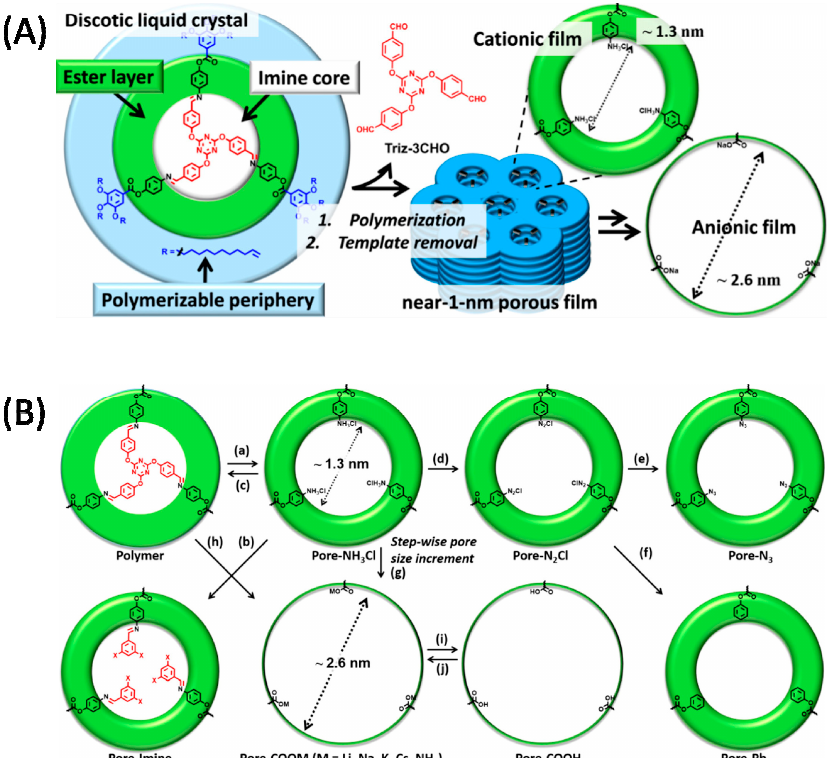
Figure 5 . Chemical pore modification of a columnar hexagonal liquid crystal polymer. ( A ) Stepwise fabrication of a nanoporous polymer with smaller cationic, or bigger anionic pores; ( B ) Scheme of pore chemistry, starting from non-porous polymer. (a) Hydrolysis of the imine linkages of the native polymer yielding the nanoporous polymer. (b) Reacting the amino groups in the pores with different aldehydes. (c) Reincorporating the template aldehyde yielding the original polymer. (d) Conversion of the ammonium groups in the pores to the corresponding diazonium salt. (e,f) Reacting the diazonium salt with NaN 3 and H 3 PO 2 to fabricate porous polymers with neutral azide ( − N 3 ) and phenyl ( − Ph) groups at the pore surface. (g) Hydrolysis of the ester groups present in the inner core of the polymer to furnish a porous polymer containing bigger anionic pores. (h) Hydrolysis of the native polymer to directly form the porous polymer with big anionic pores. (i) Acidic treatment of the anionic pore interior to yield neutral − COOH groups in the pores. (j) Treatment of the pores lined with − COOH groups with hydroxide salts of Li + , Na + , K + , Cs + , and NH 4+ yielding anionic pores with different counterions. Adapted from [27], under the terms of a Creative Commons Non-Commercial No Derivative Works (CC-BY-NC-ND) Attribution License.